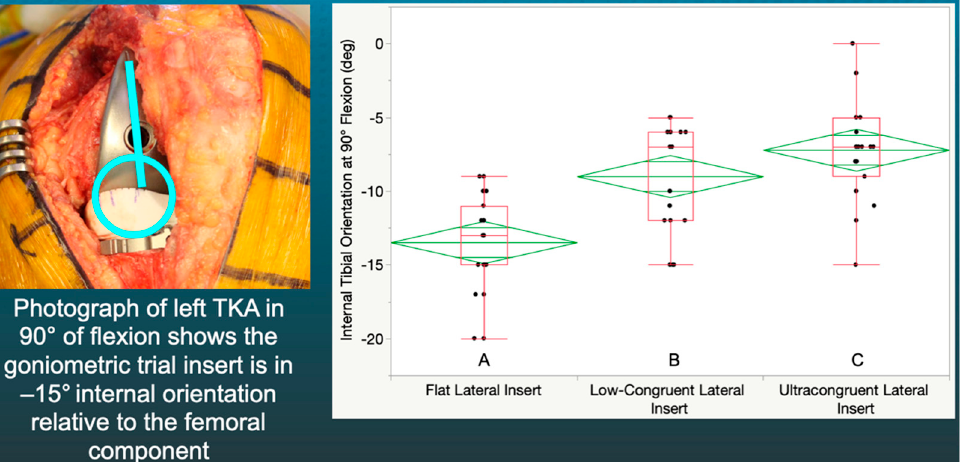
Figure 4. Box plot showing internal tibial orientation in 90° flexion for three insert congruencies. Congruencies not connected by the same letters were significantly different.